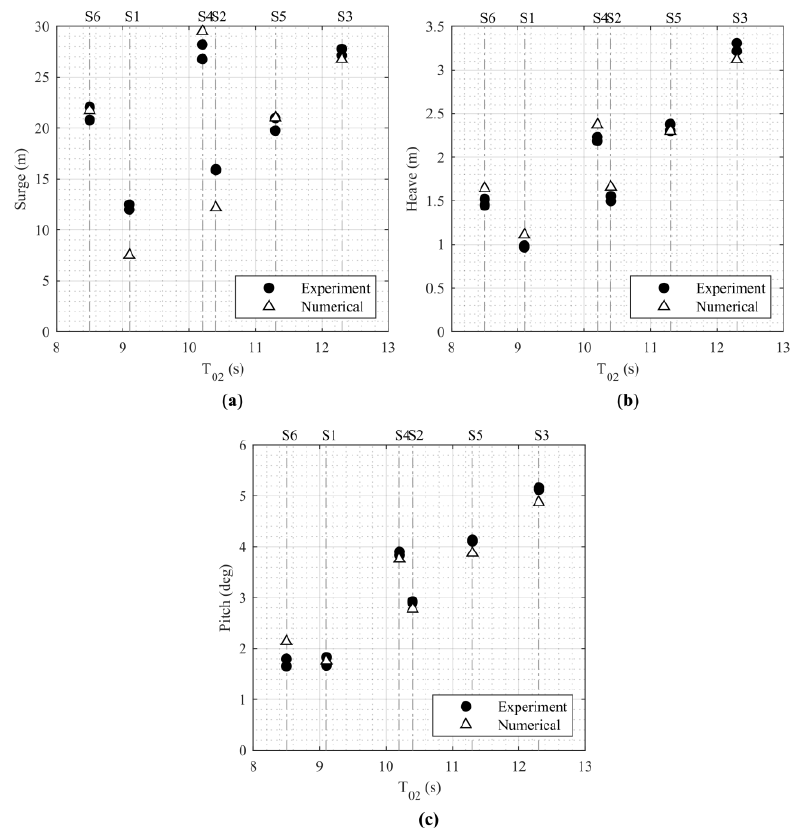
Figure 18. (a) Surge, (b) Heave and (c) Pitch comparison of WEC motions determined from and numerical model in full-scale values for series experiments and numerical model in full-scale values for series M2.